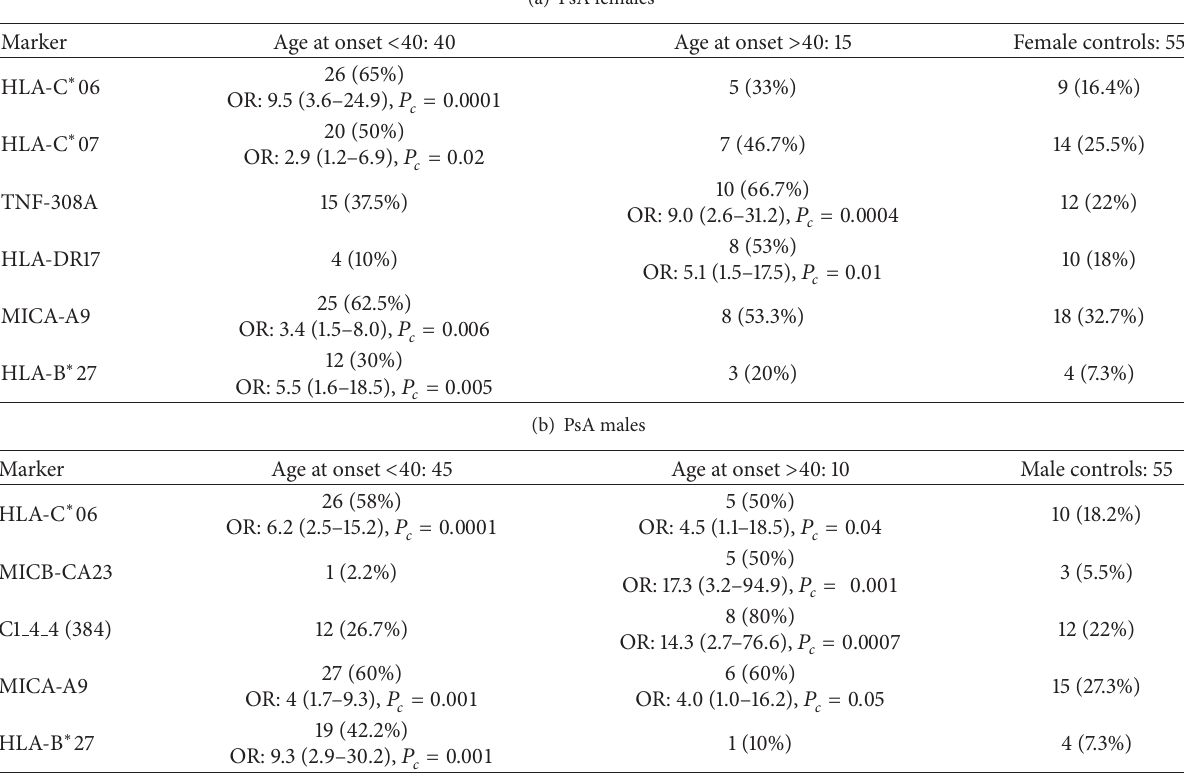
Table 4: Distribution of most significant markers in men and women with PsA according to age at psoriasis onset (cutoff: